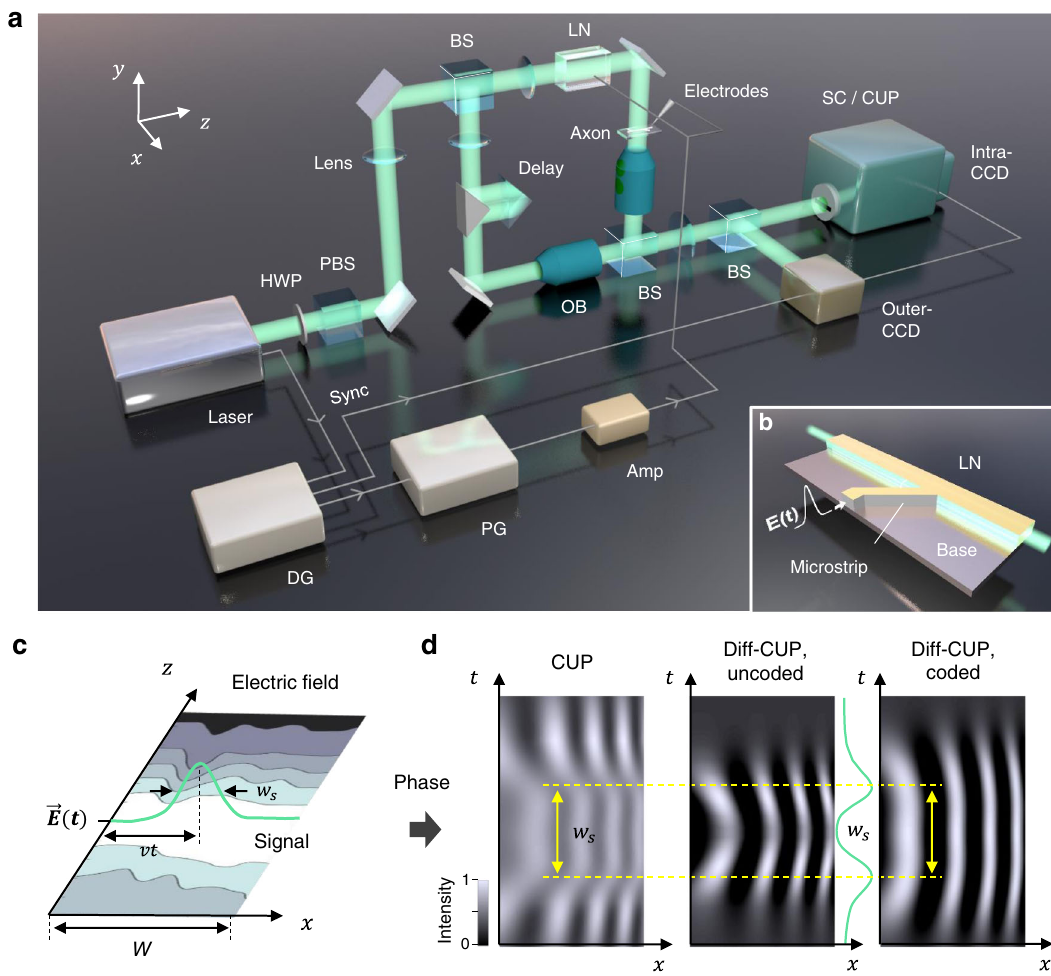
Fig. 1 | Diff-CUP system. a Schematic of the Diff-CUP system. Amp ampli fi er, BS beamsplitter, CCD charge-coupled device camera, DG delay generator, HWP half- wave plate, LN lithium niobate crystal, OB objective lens, PBS polarizing beams- plitter, PG pulse generator, SC streak camera, Sync synchronization. b Delivery of anEMP, E t ð Þ , to the LN crystalthrough a custom-designedmicrostrip transmission line. c Spatiotemporalelectric fi elddistribution of the signalpropagating inthe LN